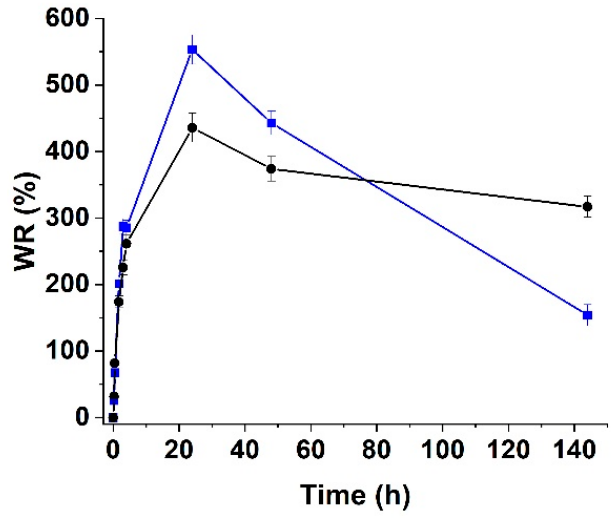
Figure 5. Swelling profiles of H ALG (blue line) and H ALG-GO (black line) at pH 7.4.